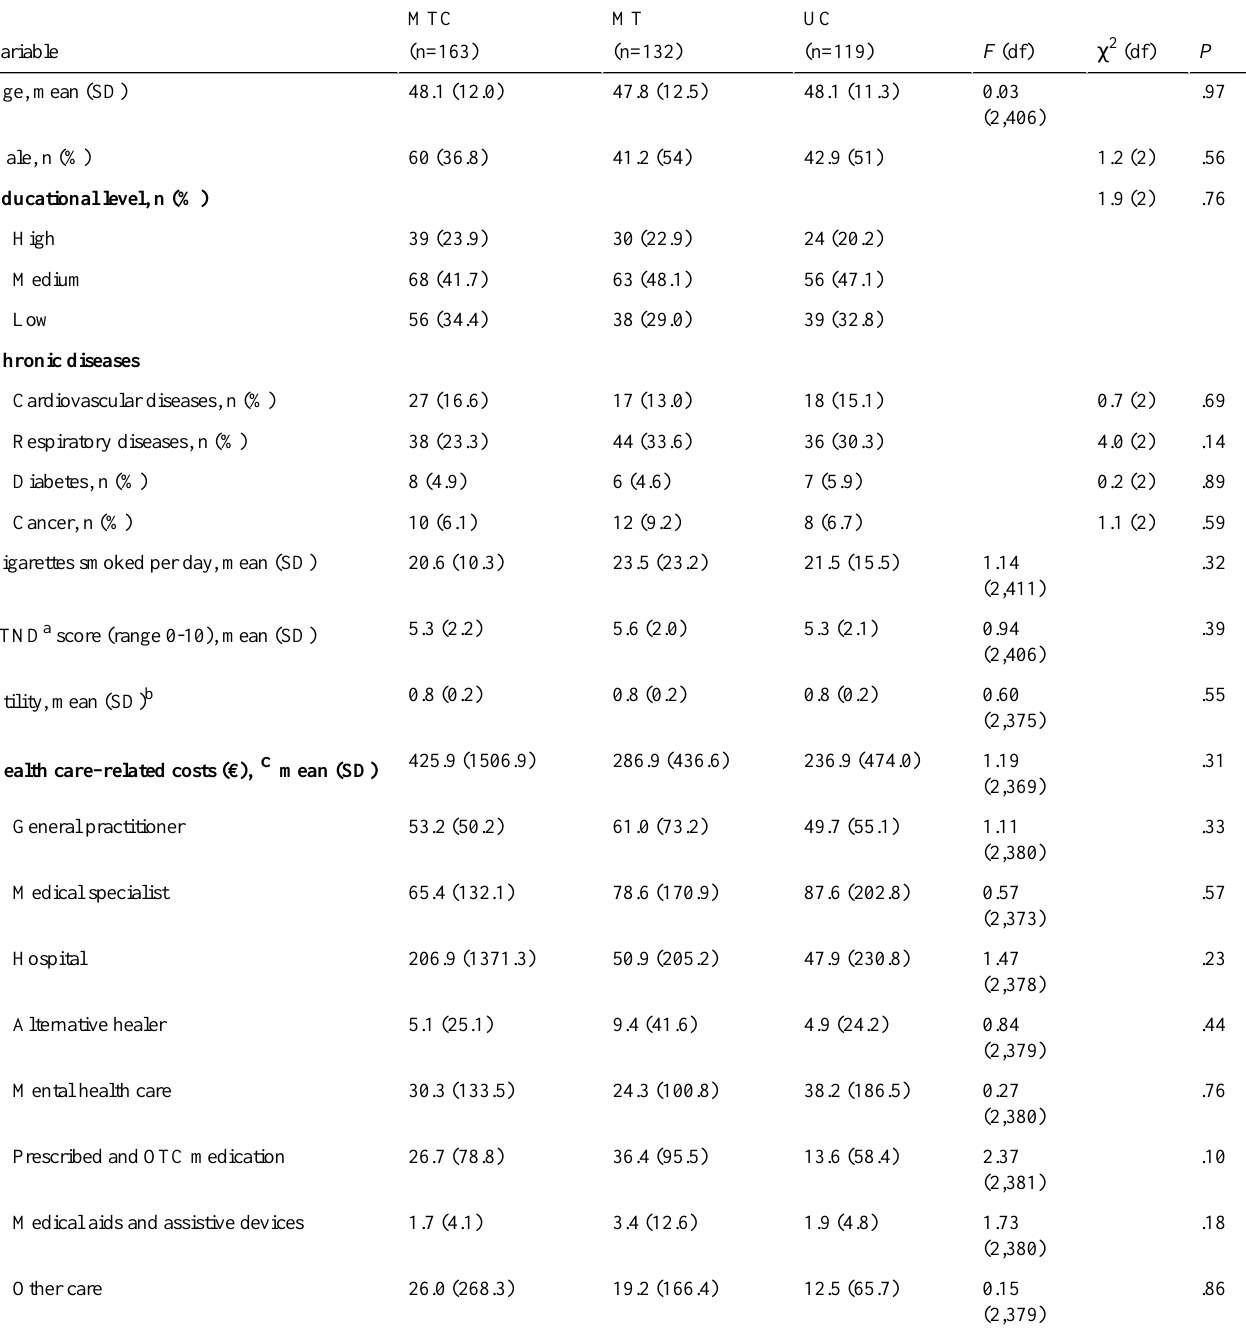
Table 1. Comparability of the 3 groups, multiple tailoring and counseling (MTC), multiple tailoring (MT), and usual care (UC), regarding demographics, baseline values of outcomes, and health care–related costs over the past 3 months (N=414).